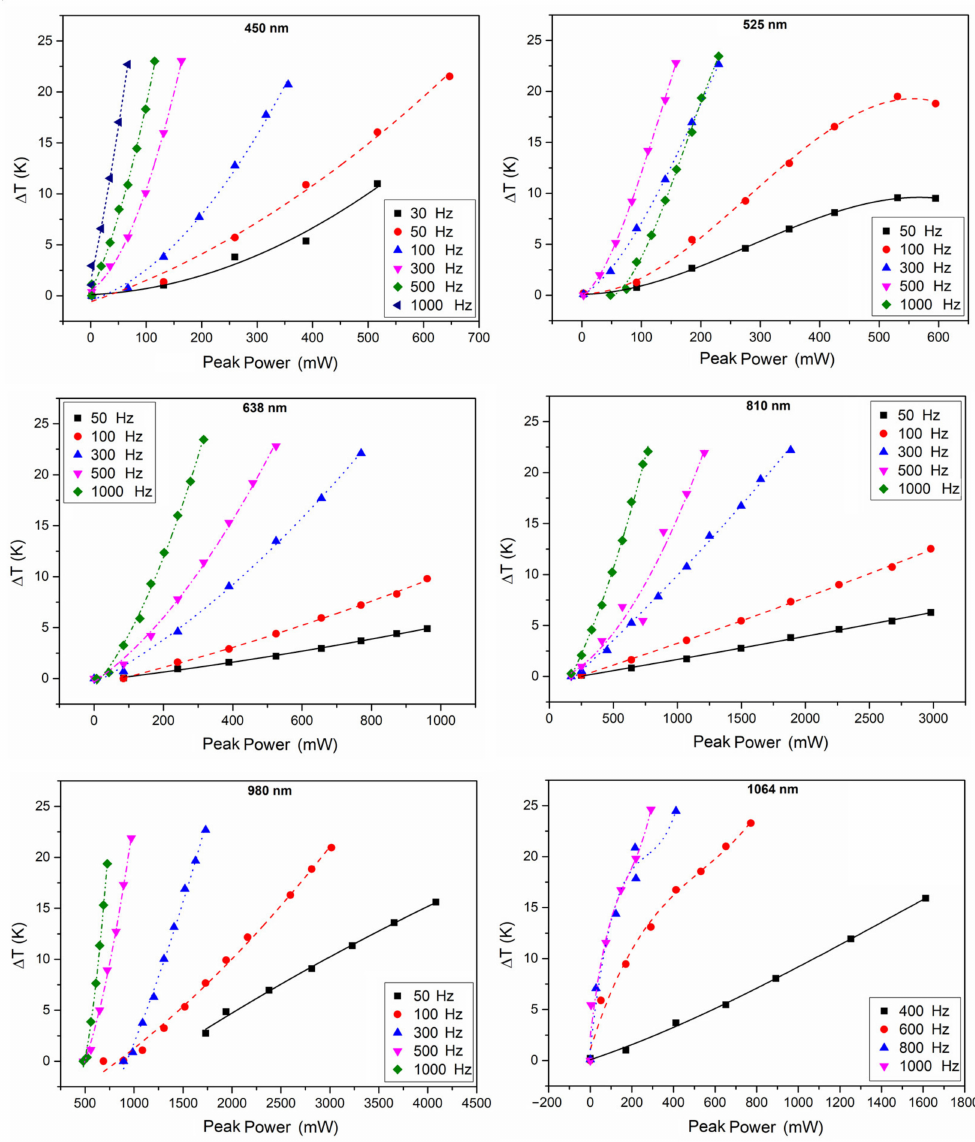
Figure 4. The relationship between the temperature rise owing to photothermal effect and the peak power of pulsed lasers with different wavelengths and different pulse